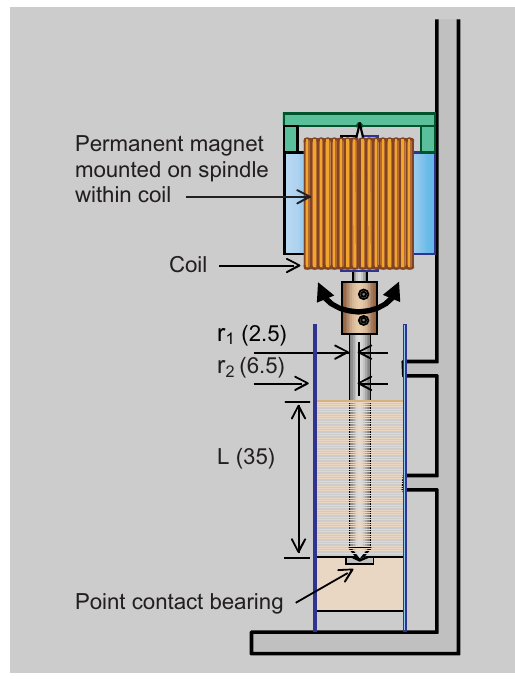
Figure 7 (right): Diagram of the rotary actuator in coaxial rotation rheometer